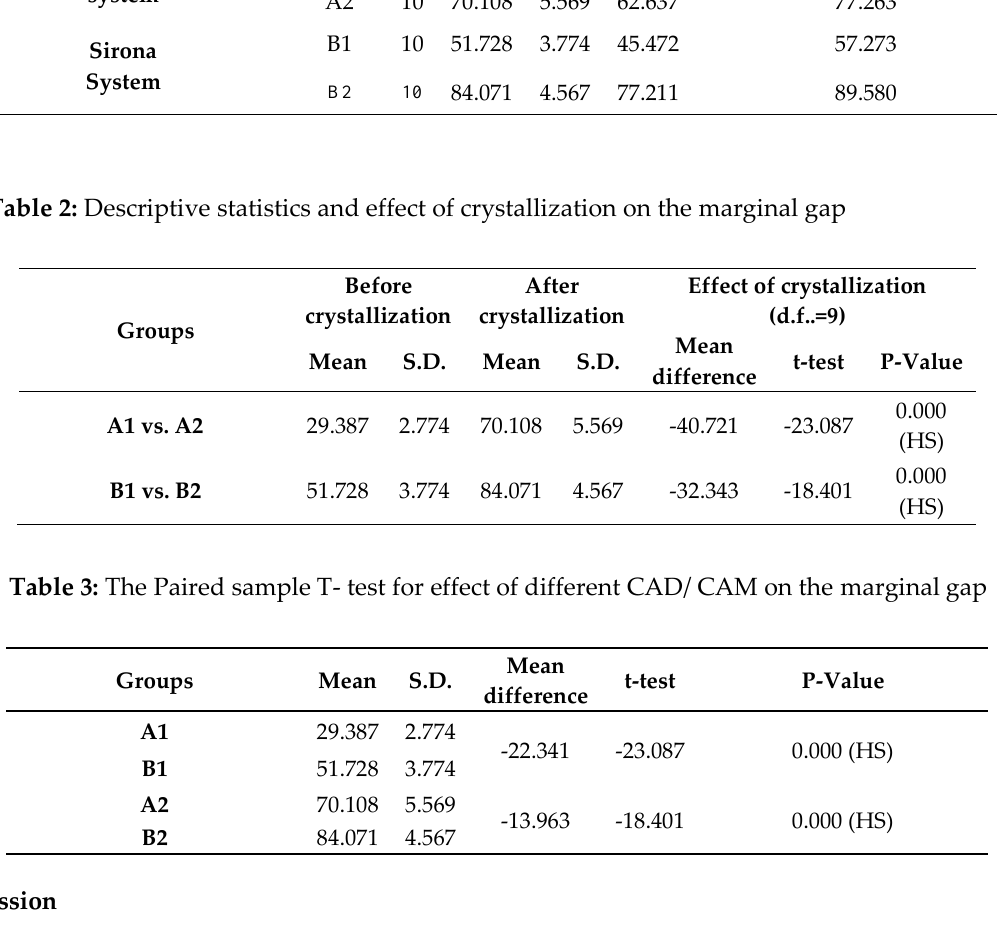
Table 1: Descriptive statistics of the marginal gap (µm) in each group Systems